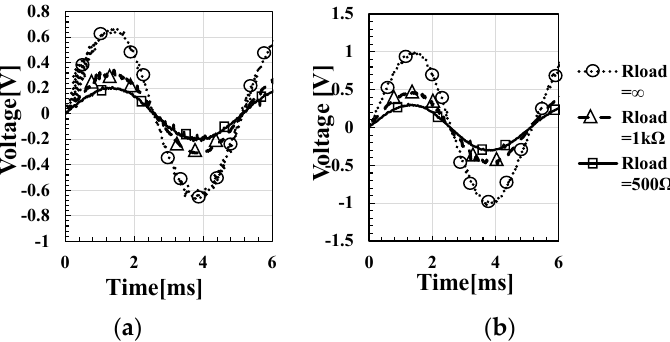
= 195 Hz): ( a ) α = 0.28 G, ( b ) α = 0.5 G. IN